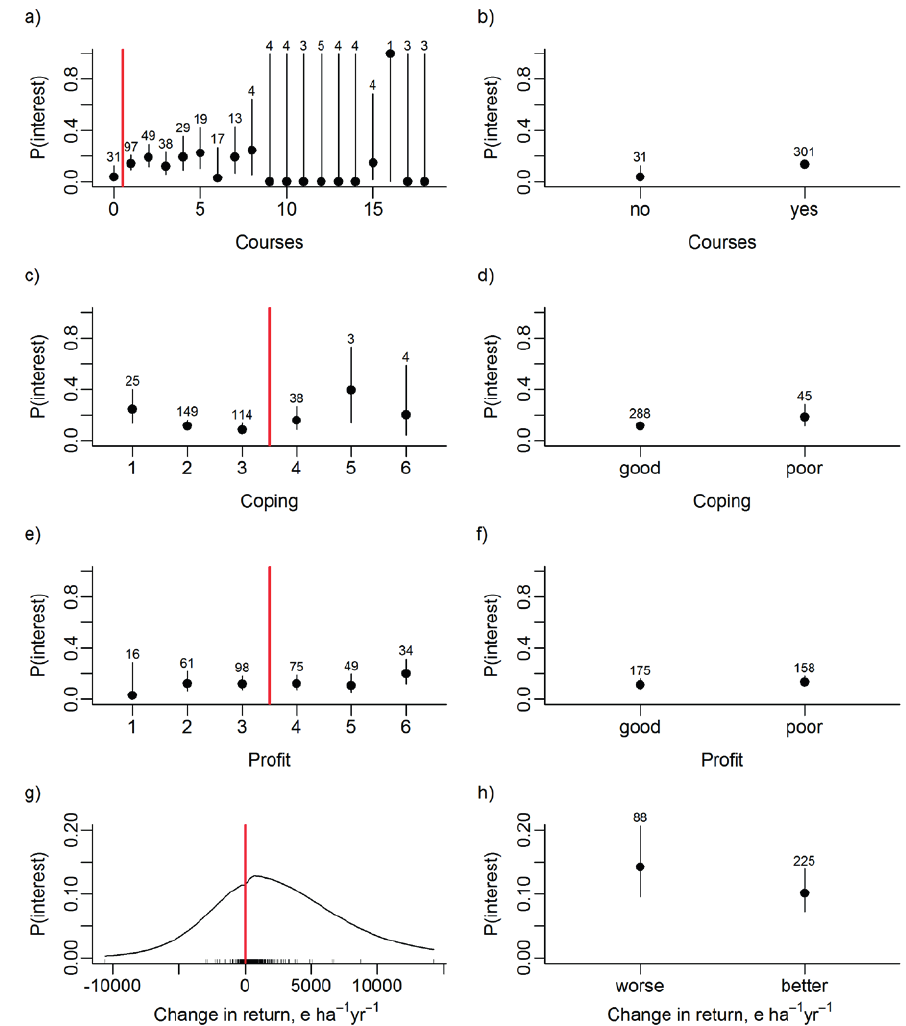
Fig. S4. Probability of interest in organic production as a function of those explanatory variables, which had to be aggregated subjectively.